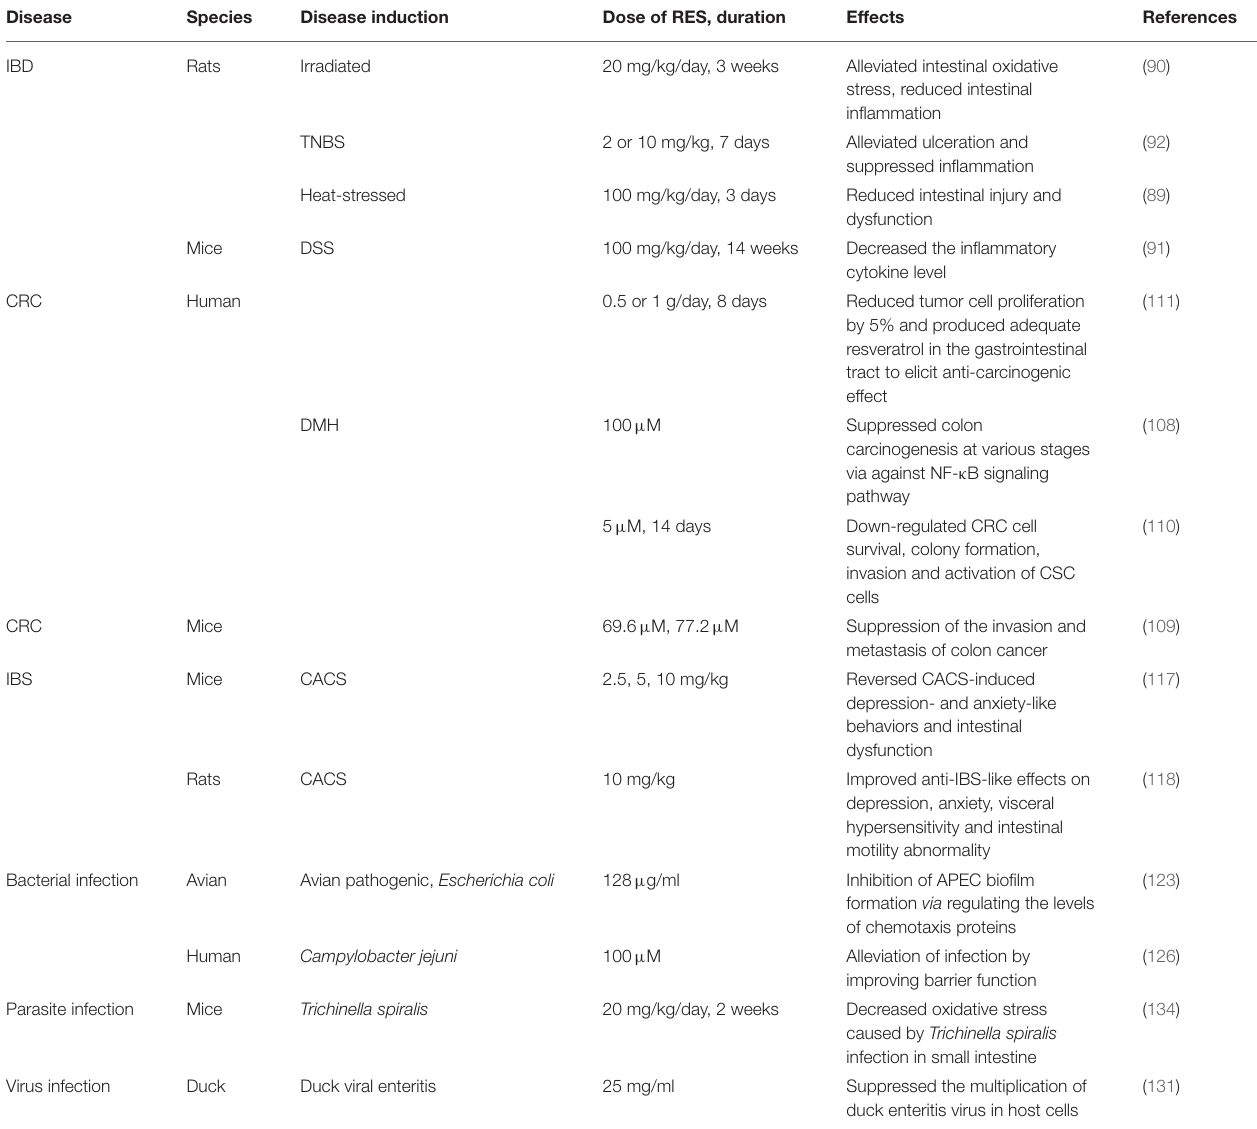
TABLE 1 | Resveratrol and intestinal